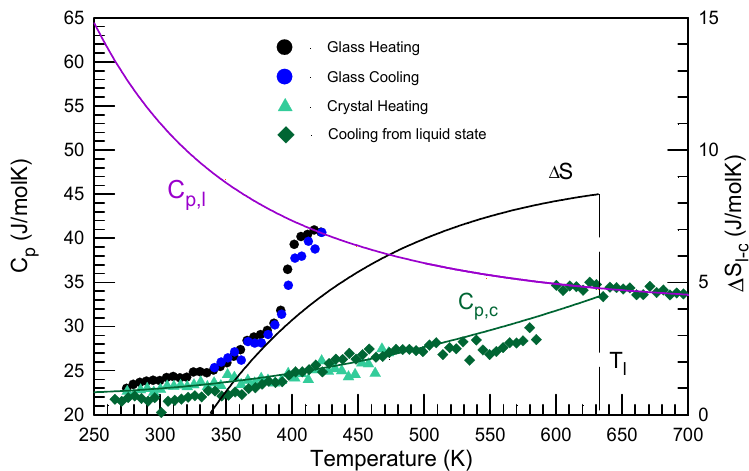
Figure 3. C p of the Au 49 Cu 26.9 Ag 5.5 Pd 2.3 Si 16.3 alloy in liquid (l), glassy and crystalline (c) state as a function of temperature (left Y axis) and the entropy difference between the liquid and crystalline state Δ S . The Kauzmann temperature is 340 K. Reproduced from [64] with permission of Elsevier. It was also suggested that a configuron (broken bond) phase forms in amorphous